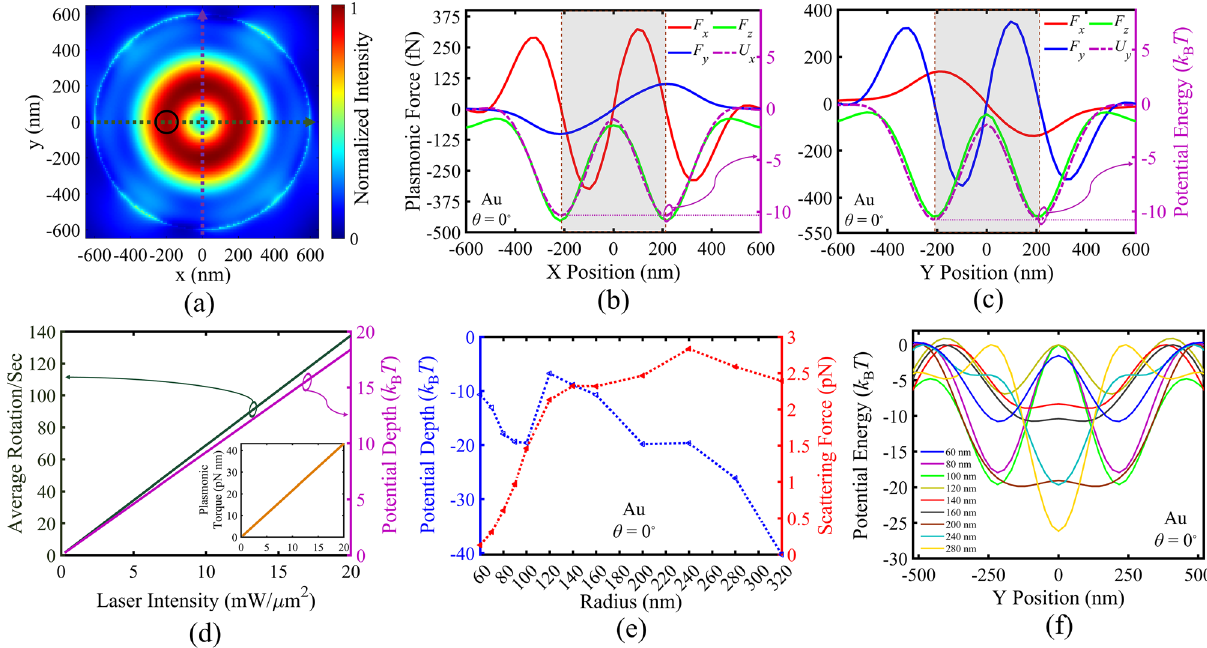
Figure 8. ( a ) Normalized electric field intensity distribution of generated PV in MIM structure, and direction of particles movement. Plasmonic force analysis for a gold sphere (shown by black circle) with the radius of 60 nm in the PV field: ( b , c ) Calculated plasmonic forces F x , F y , F z and the corresponding potential well at various x -offsets and y -offsets along the dashed lines, respectively, for θ = 0°. The ring locations are labeled by brown dashed lines. Highlighted areas denote inside the vortex ring. ( d ) Rotational speed, Potential depth and plasmonic torque of a 60 nm gold particle as a function of illumination intensity. ( e , f ) Calculated scattering forces and the corresponding potential well along y -offsets for different sizes of gold particles for I 0 = 11.5 mW/ µm 2